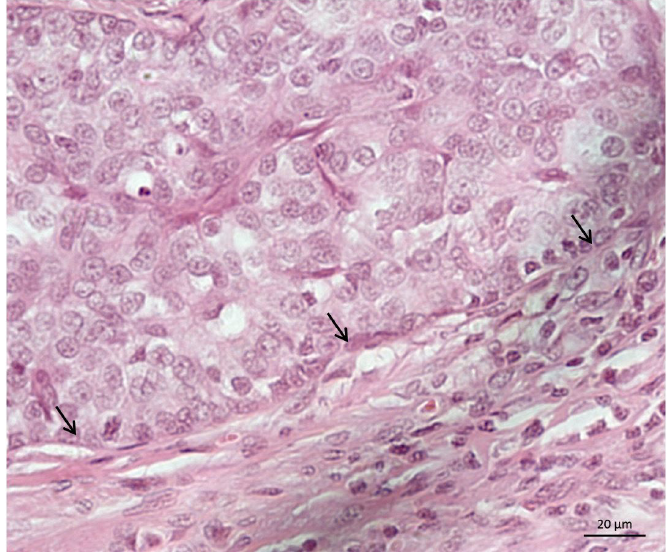
Figure 4. Proliferation of neoplastic cells in cluster arrangement with broad and eosinophilic cytoplasm, rounded to ovoid nucleus and evident nucleolus. The arrows separate the neoplastic cells and the moderate fibrous stroma, H&E,